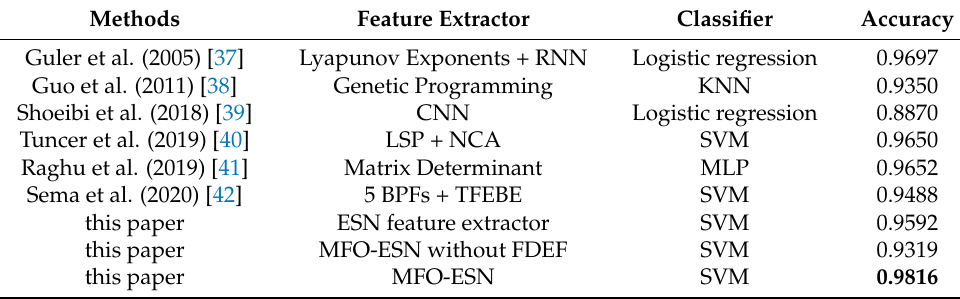
Table 1. Comparison of MFO-ESN + SVM with other